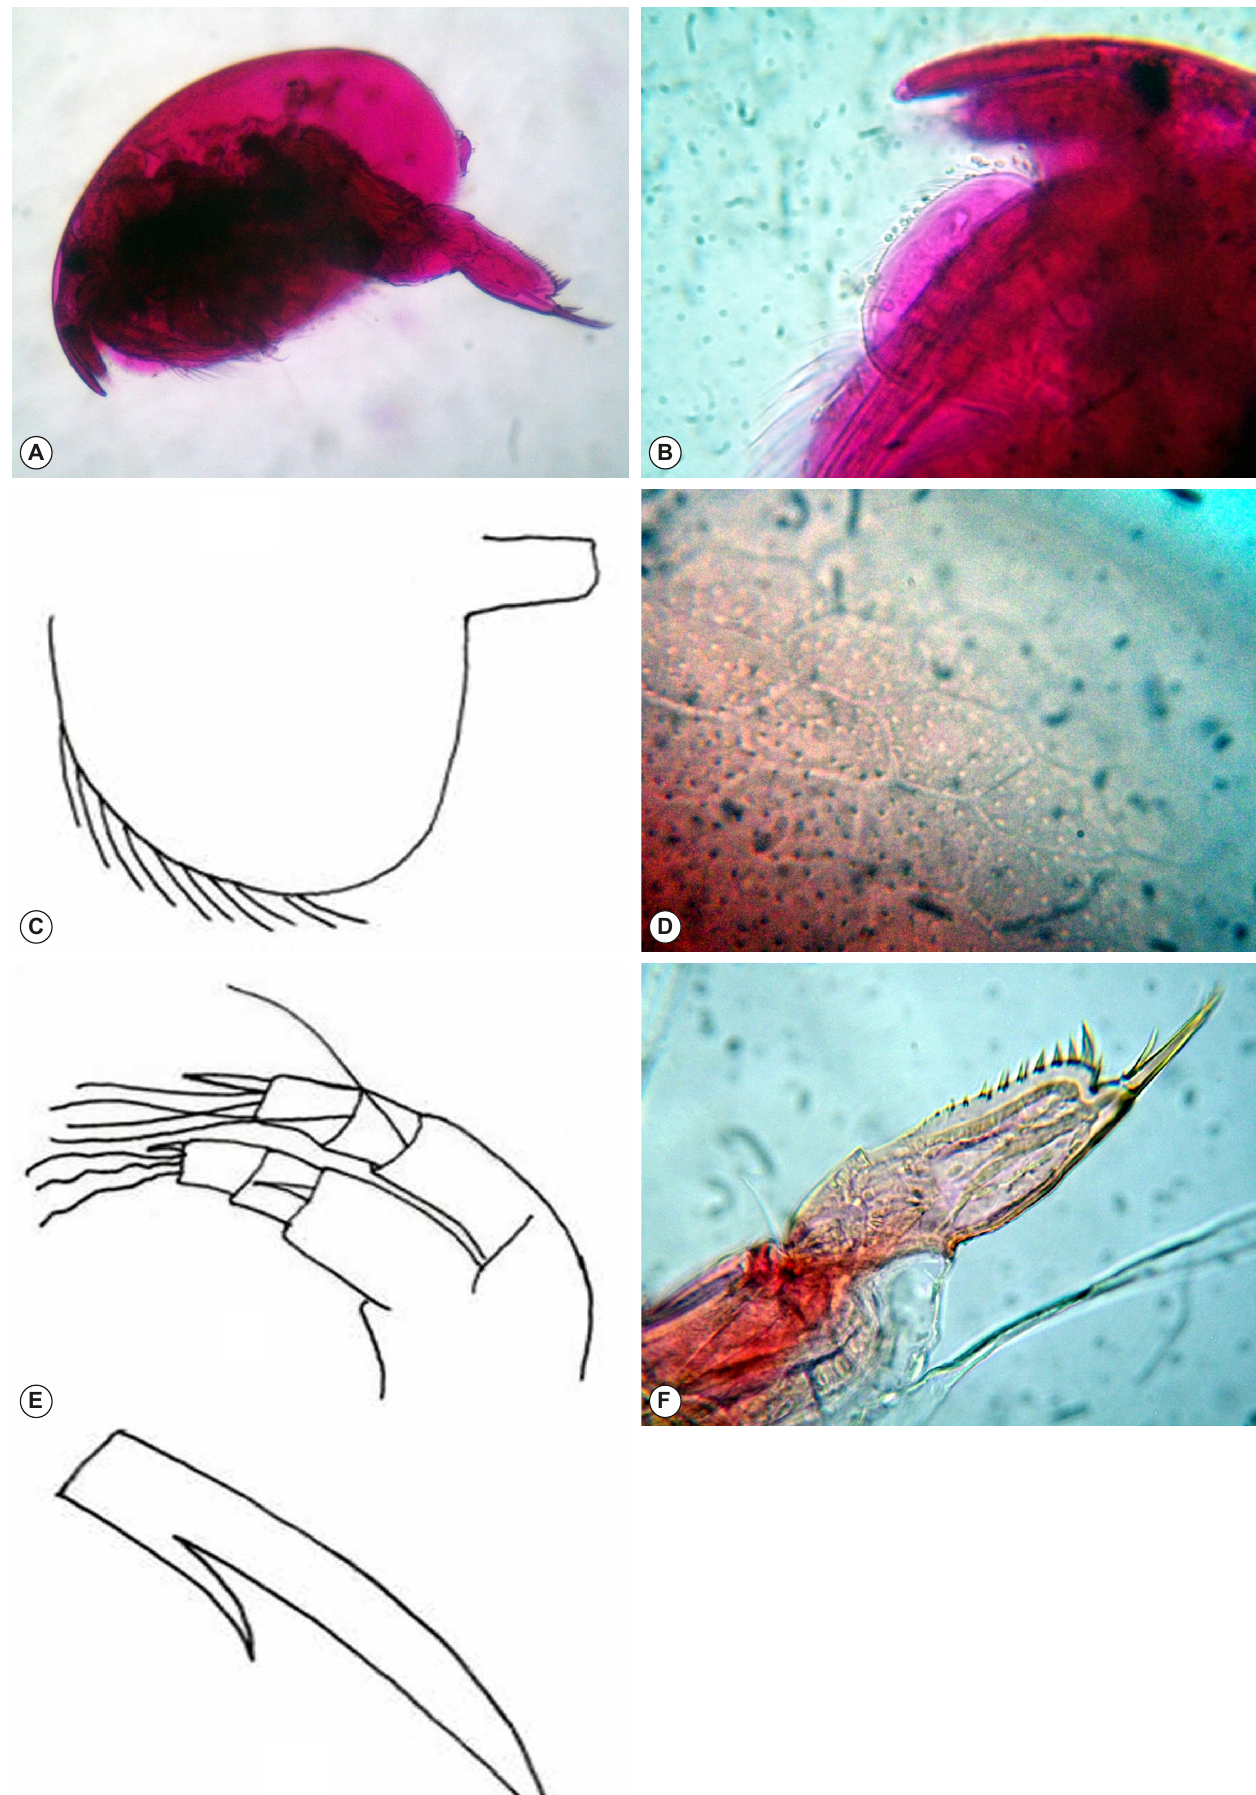
Figure 9. Oxyurella